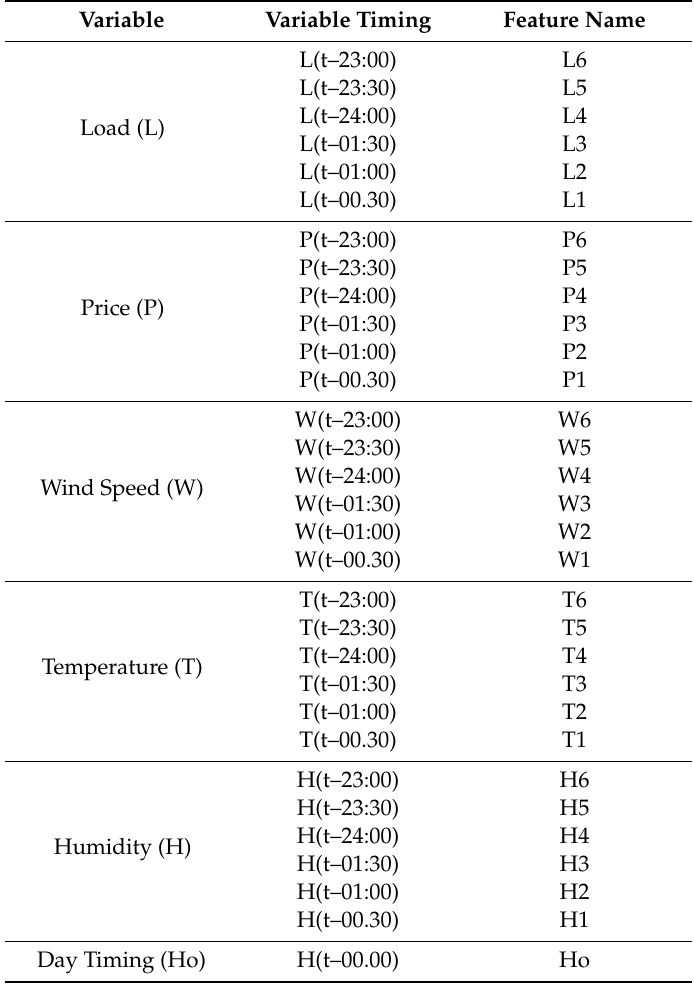
Table 1. List of features which are assumed a ff ect half-hourly